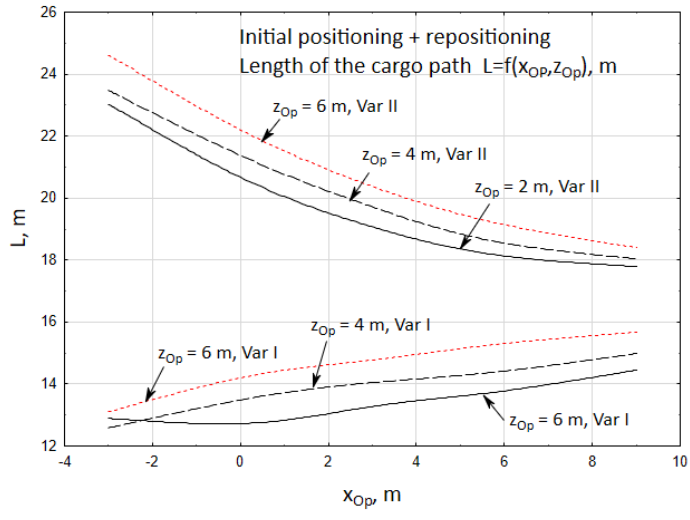
Figure 18. Length of the path of the carried cargo L , s